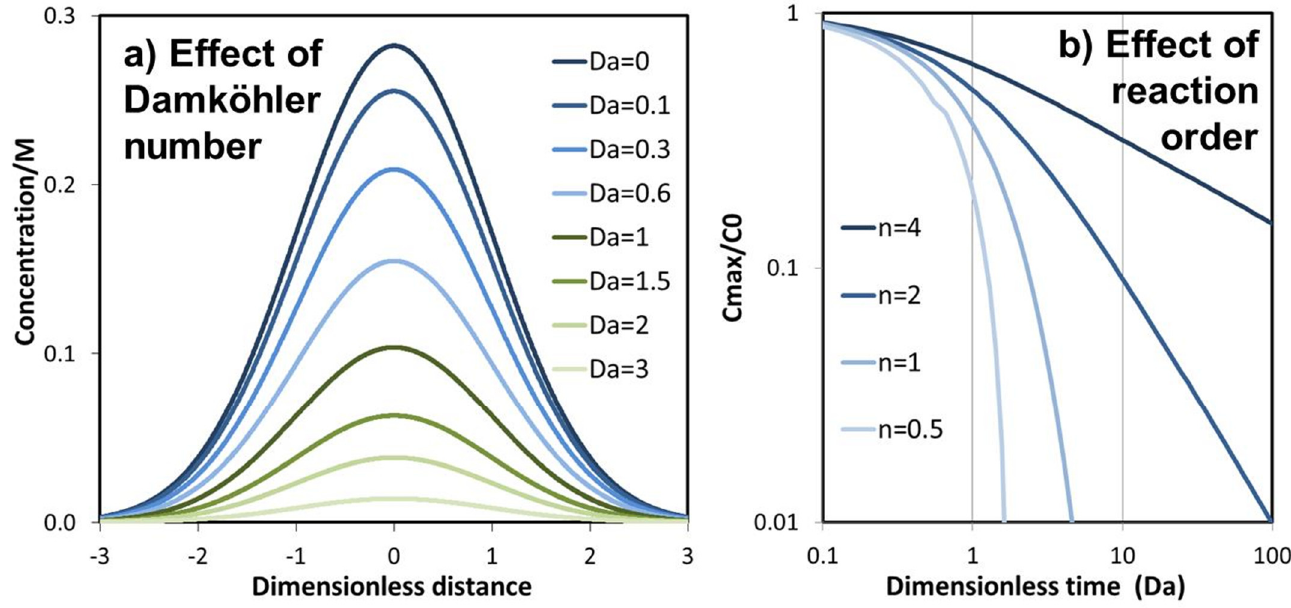
Figure 8. Dimensionless concentration versus dimensionless distance after a pulse injection of a tracer suffering first order decay ( a ). The reactions barely affect the solute, if Da < 0.1, but make it disappear for Da > 3. This is not necessarily true for non-linear kinetics ( b ). Da = 1 implies a sizeable reaction but note that significant amounts of solute remain for Da = 100, if n = 4. Also note the abrupt approach to zero for n < 1, which may cause convergence problems.